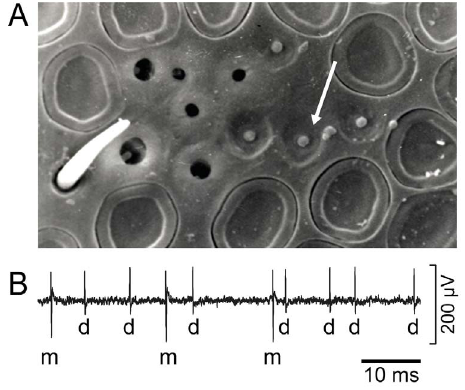
Figure 1. Scanning electron micrograph of hygroreceptive sensilla on male honeybee antenna and extracellular recorded activity of moist and dry cell. A. The cap of the sensillum ( arrow ) is visible in the central opening of a swallow cuticular depression of the antennal surface. B. Large amplitude impulses are produced by moist cell ( m ) and small amplitude impulses by dry cell ( d ). Amplitude differences are fairly typical.